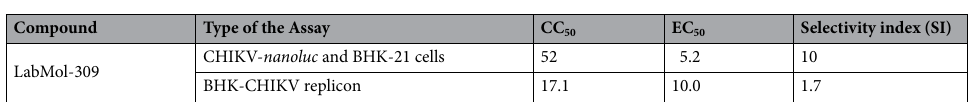
Table 3. Effect of the compound on the viability of BHK-21 cells (CC 50 ) and the viral replication of CHIKV (EC 50 ) in 16 h